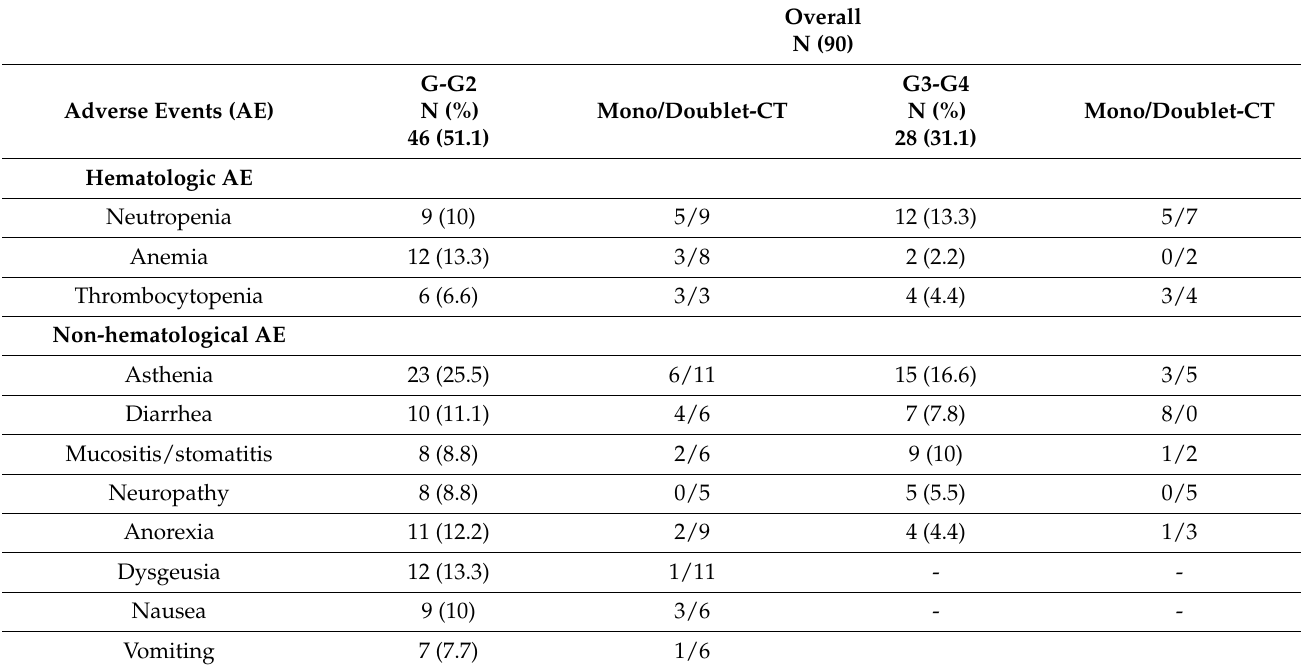
Table 2. Hematological and nonhematological AE according CTCAE v.4.